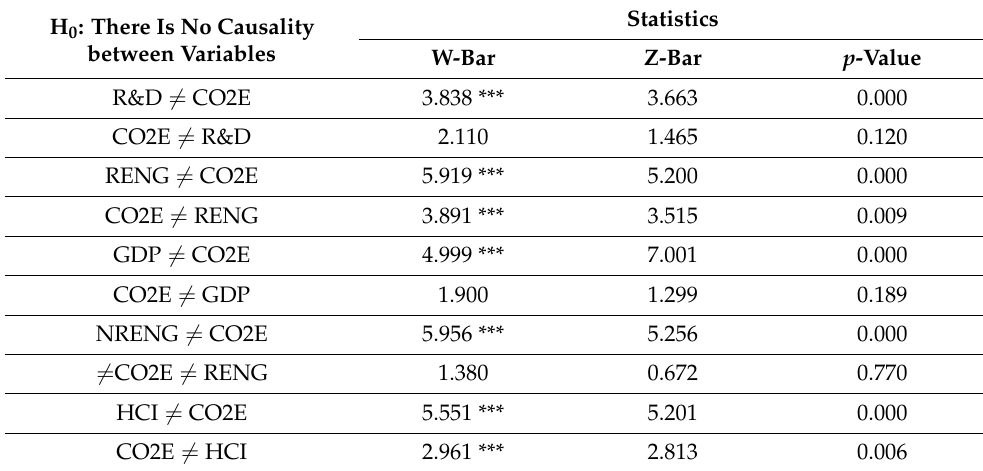
Table 7. Results of the non-causality